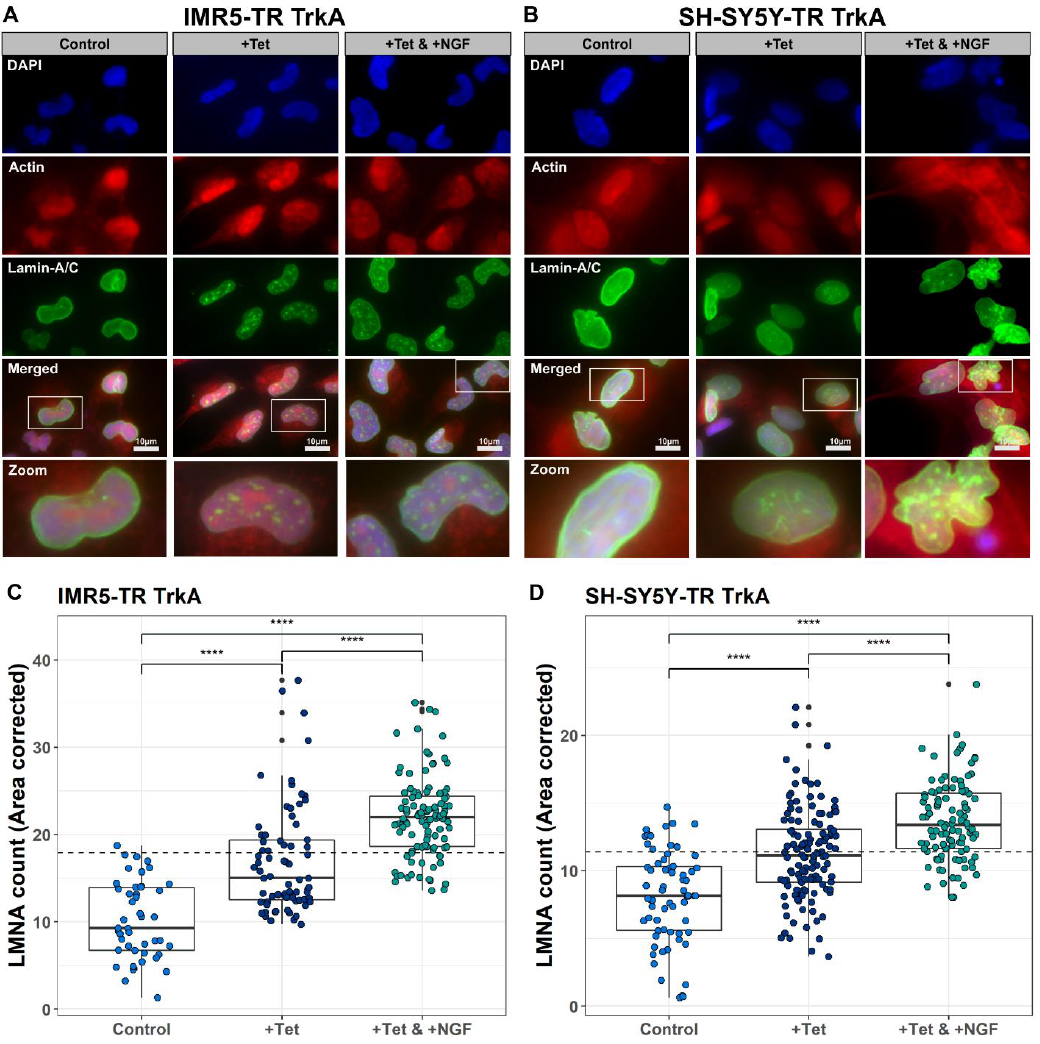
Figure 6. Changes in nuclear localization of LMNA upon NTRK1 expression and activation. Representative immunofluo- rescence stainings of LMNA (green) illustrating accumulation of LMNA within foci inside the nuclei upon NTRK1